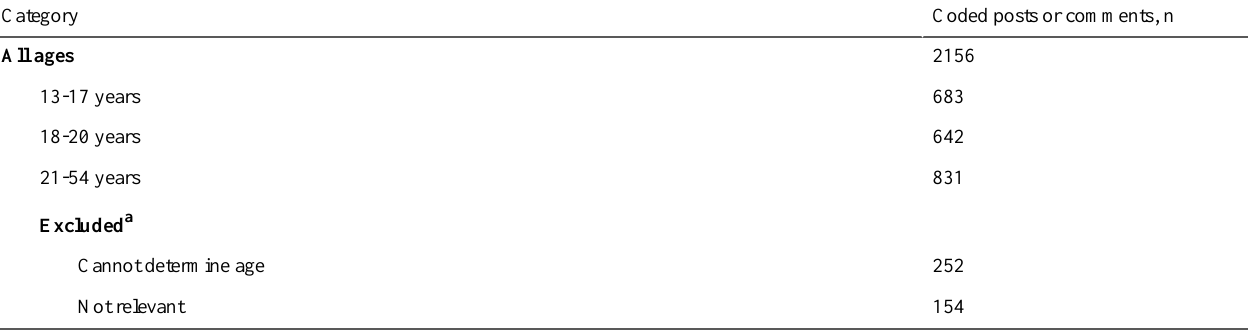
Table 1. Number of manually labeled Reddit posts by age category (December